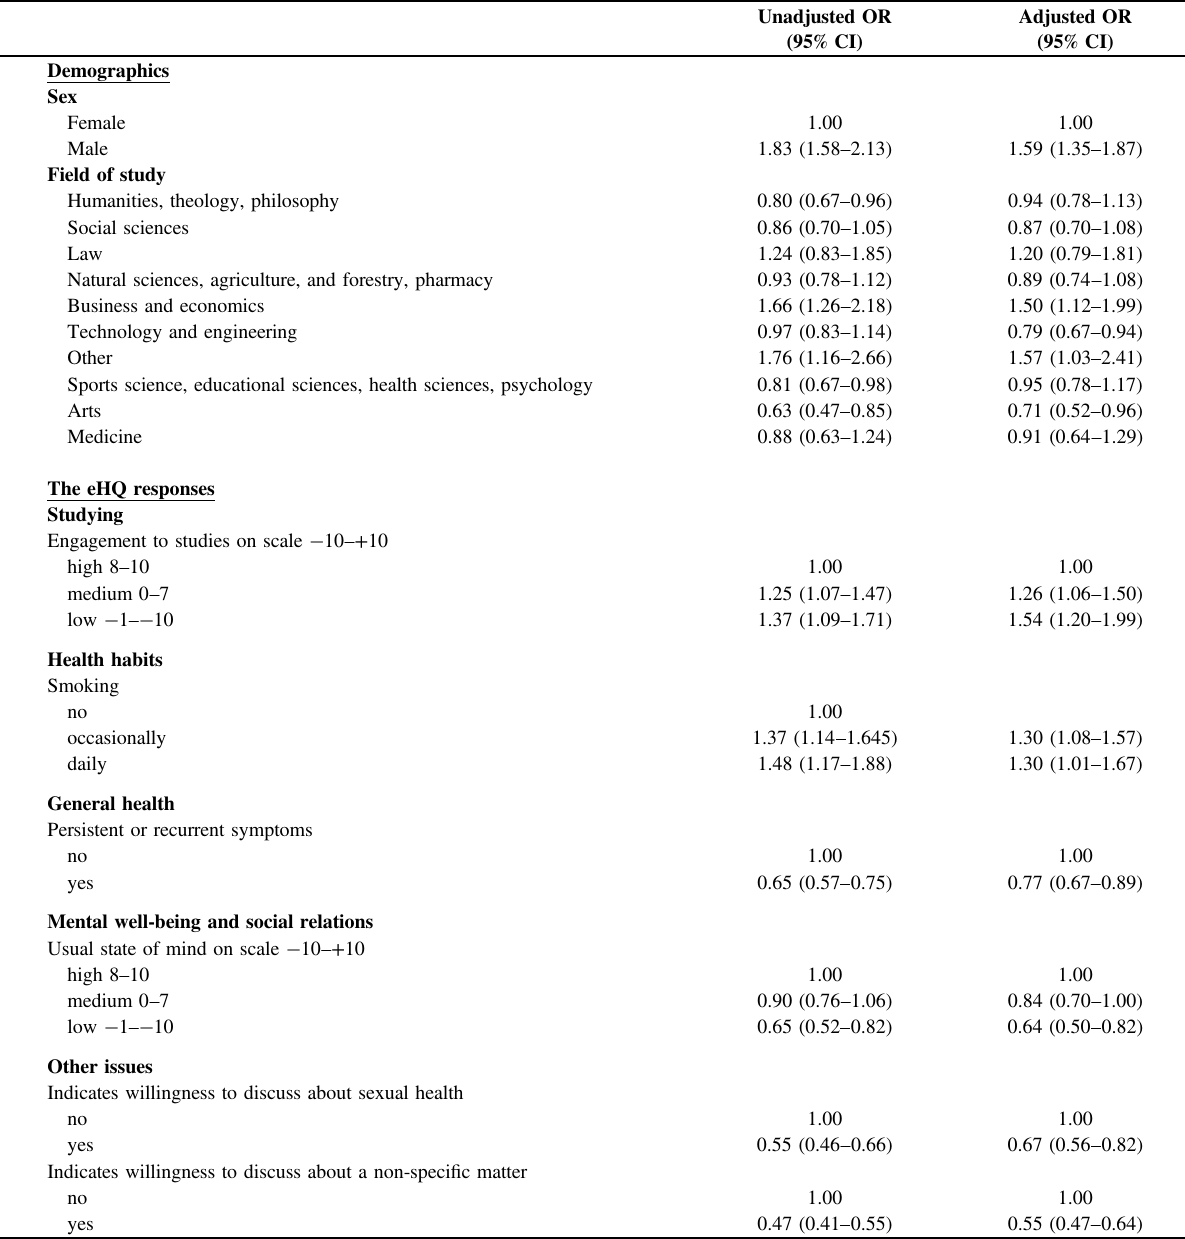
Table 3 Univariate and multivariable logistic regression analysis showing predictors of health check